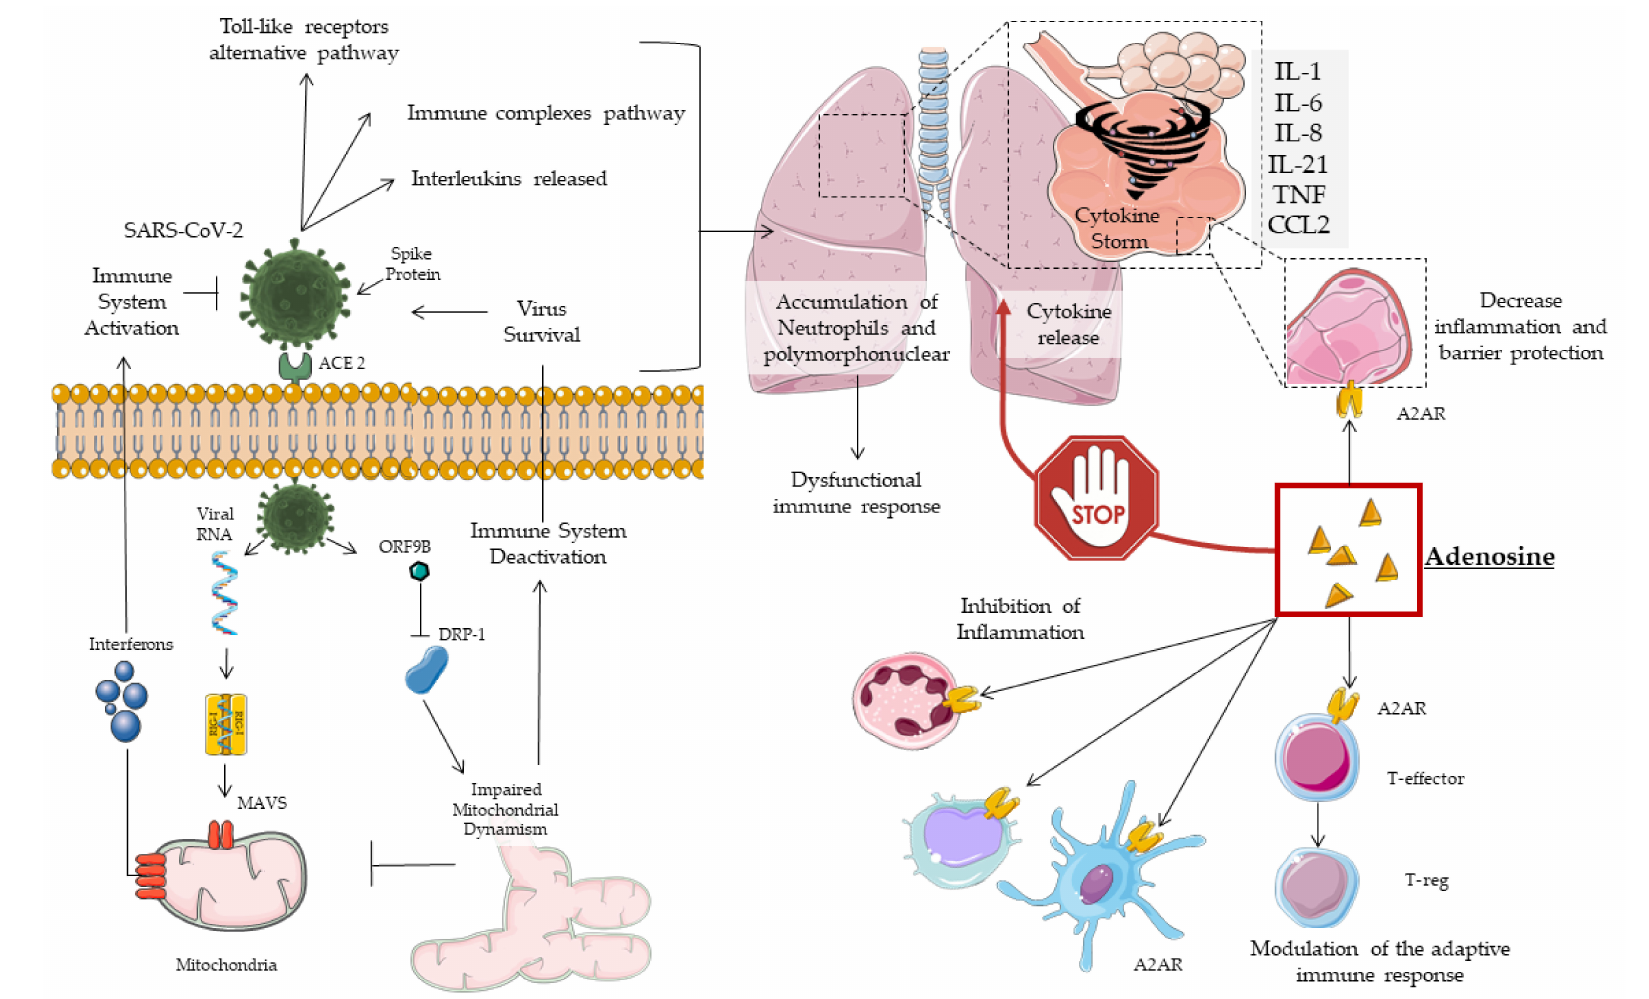
Figure 1. Mechanisms of adenosine action on